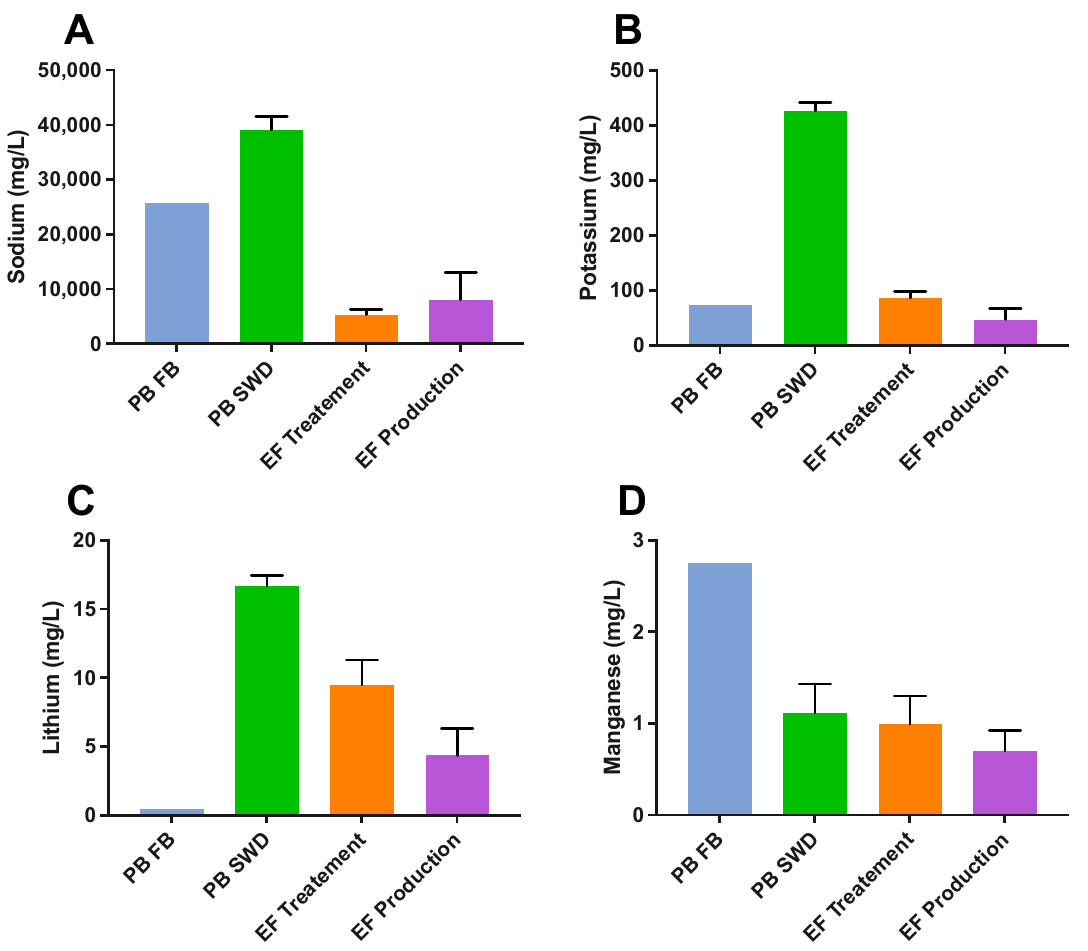
Figure 6. Metals in produced waters that primarily contribute to TDS levels. The average concentrations for ( A ) sodium, ( B ) potassium, ( C ) lithium, and ( D ) manganese are presented, along with error bars, which represent the standard error of the mean.